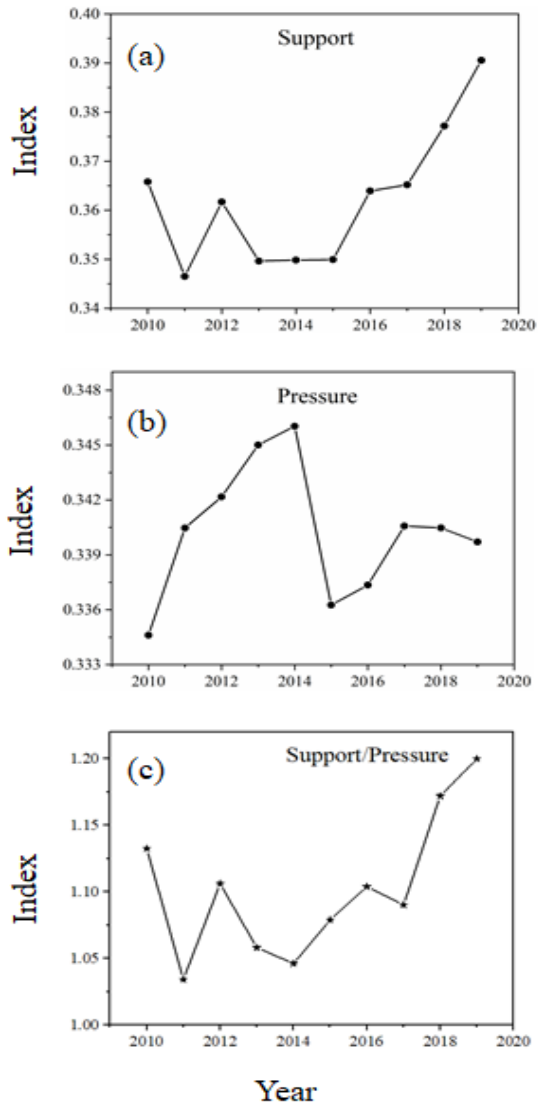
Figure 4. Variation plot of indicators for support, pressure, and WRECC. Here, ( a ) represents support index, ( b ) represents pressure index, while ( c ) represents the ratio of support for pressure.